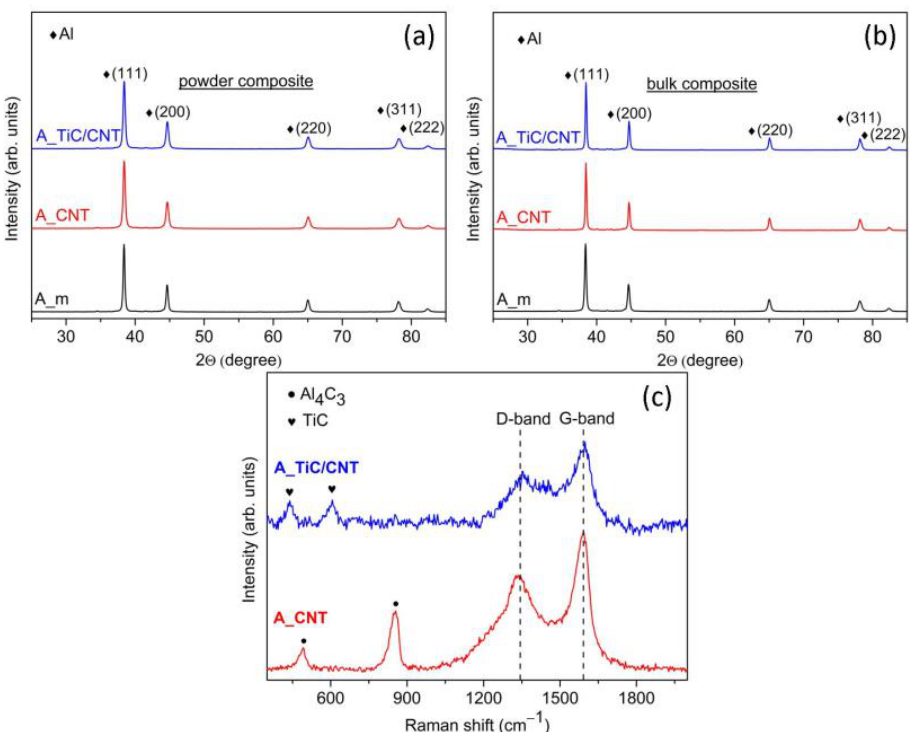
Figure 3. XRD data of powder materials ( a ), bulk samples ( b ) and Raman spectroscopy results of bulk samples ( c ).